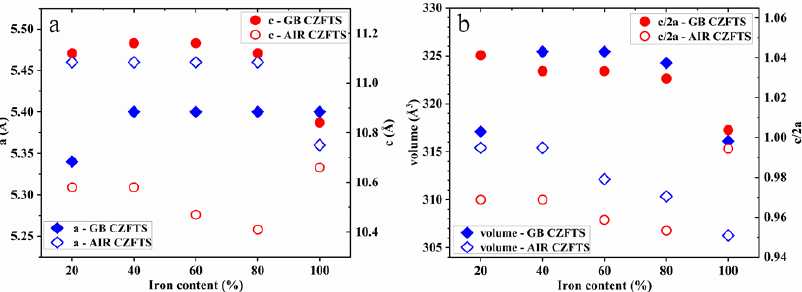
Figure 2. ( a ) Lattice parameters a and c , calculated by applying the tetragonal structure formula, and ( b ) relative volume a 2 c , lattice distortion c/2a of the 20%, 40%, 60%, 80%, and 100% C(Z,F)TS thin films, ( b ) relative volume a 2 c , lattice distortion c / 2a of the 20%, 40%, 60%, 80%, and 100% C(Z,F)TS thin films, made in glovebox and air. made in glovebox and